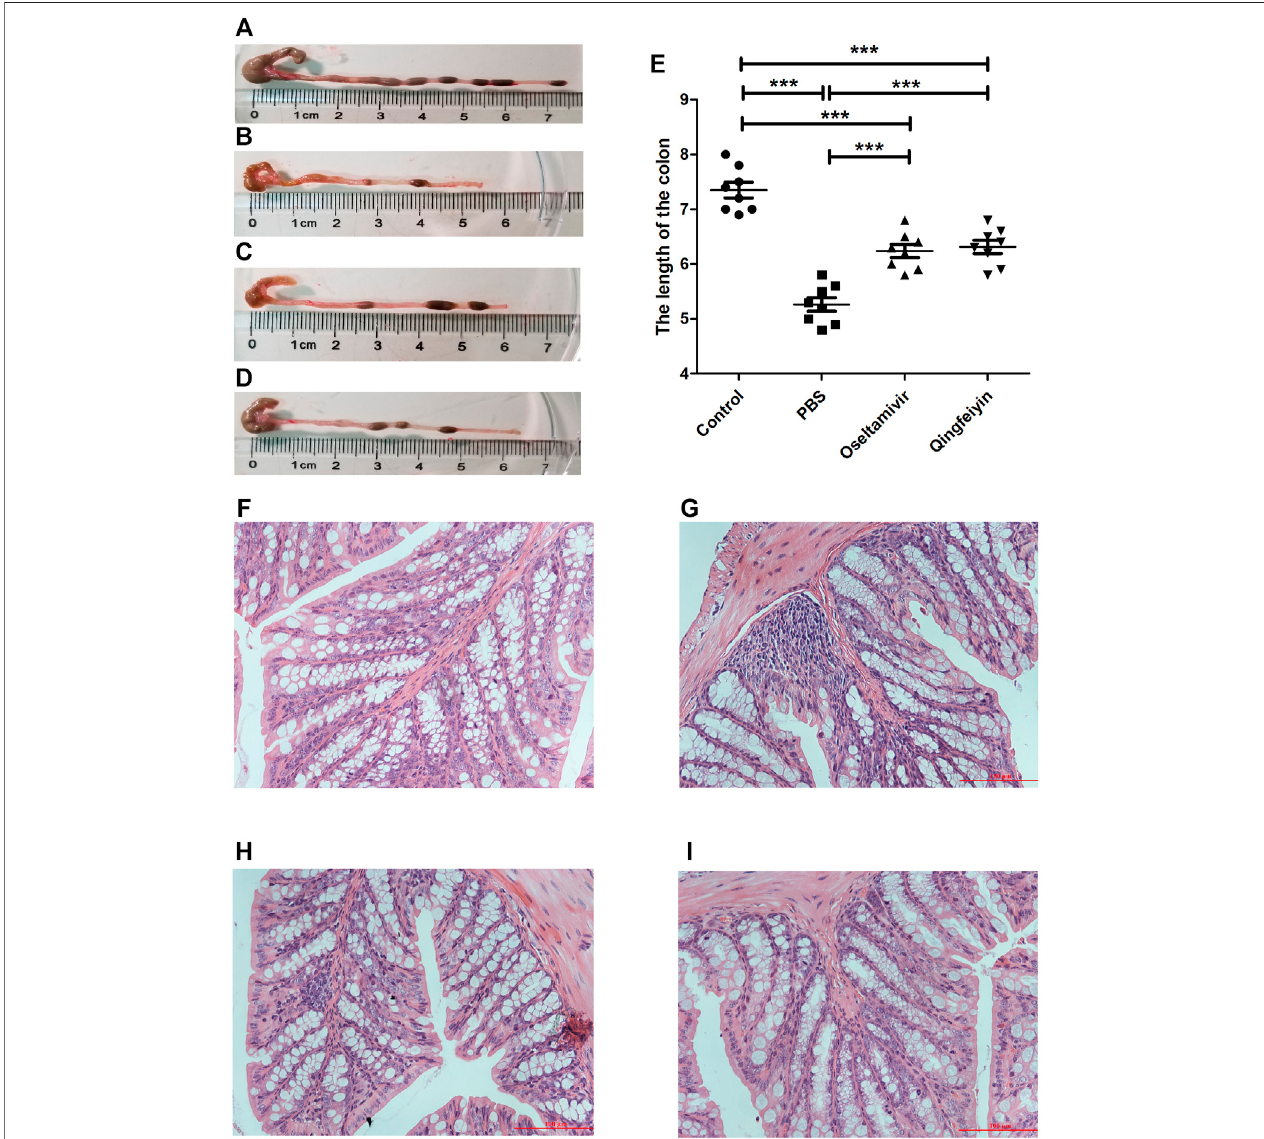
FIGURE1| TheeffectofQFYDonbodyweight,viralload,lungindex,survivalrate,andlungtissue.QFYDincreasedthebodyweightofmice (A) ,decreasedtheviral loadinthelung (B) ,lungindex (C) ,andenhancedthesurvivalrate (D) after7 daysoftreatmentwithQFYDinmiceinfectedwiththeH1N1virus. (E – H) isrepresentativeH/ E staining pictures of control, PBS, oseltamivir, and QFYD group (x 200), respectively. The data of bodyweight, lung index, and viral load were analyzed by analysis of variance (ANOVA), and the survival rate was analyzed by the Log-rank (Mantel-Cox) test. p < 0.05 means the statistical difference. * p < 0.05; ** p < 0.01; *** p <